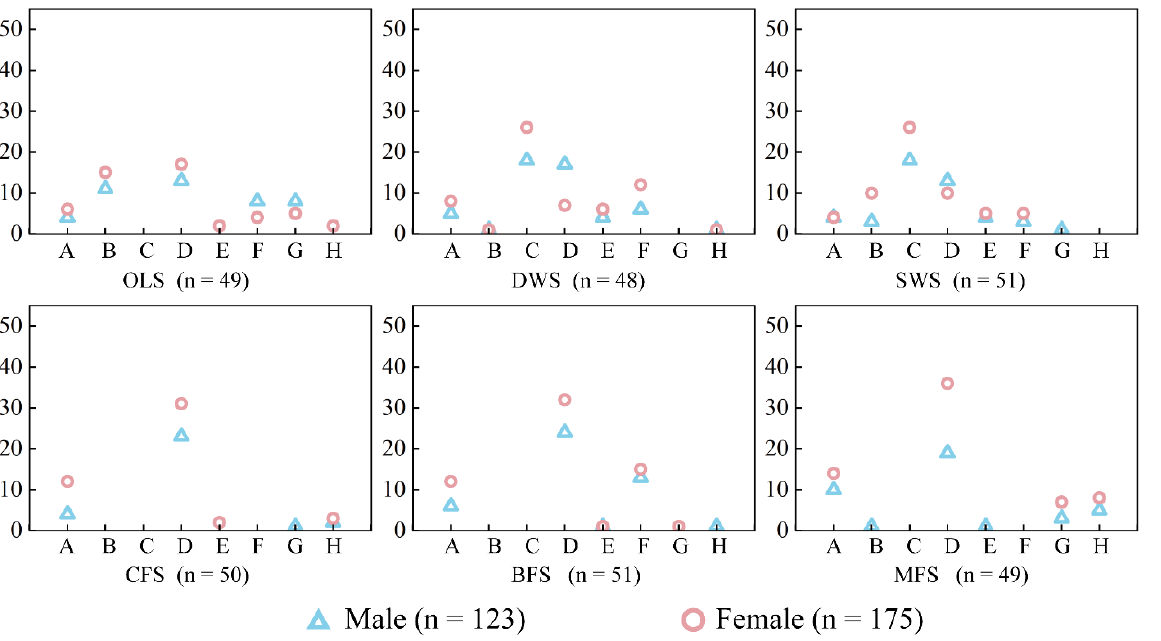
Figure 8. The number of participants with preferences for different forest landscape space elements. A: sky; B: distant mountains; C: water; D: vegetation; E: stone; F: structure; G: creatures (birds, butterflies and insects, etc.); H: natural sounds. OLS: overlook landscape space ( n = 49); DWS: dynamic water landscape space ( n = 48); SWS: static water landscape space ( n = 51); CFS: coniferous forest landscape space ( n = 50); BFS: broadleaf forest landscape space ( n = 51); MFS: mixed forest landscape space ( n = 49).